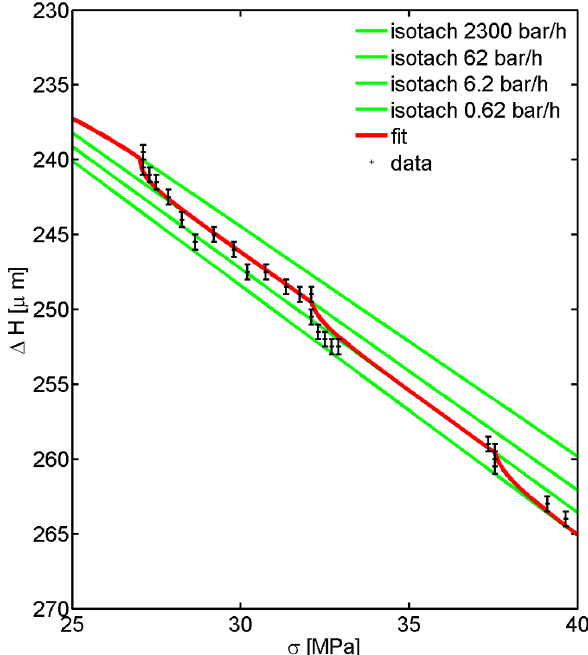
Figure 1. A compaction experiment (black) with the fit to the com- paction experiment (red) with the RTiCM compaction model (de Waal et al., 2015). The lines of constant stress-strain rate are called isotachs (green) and are lines of constant loading